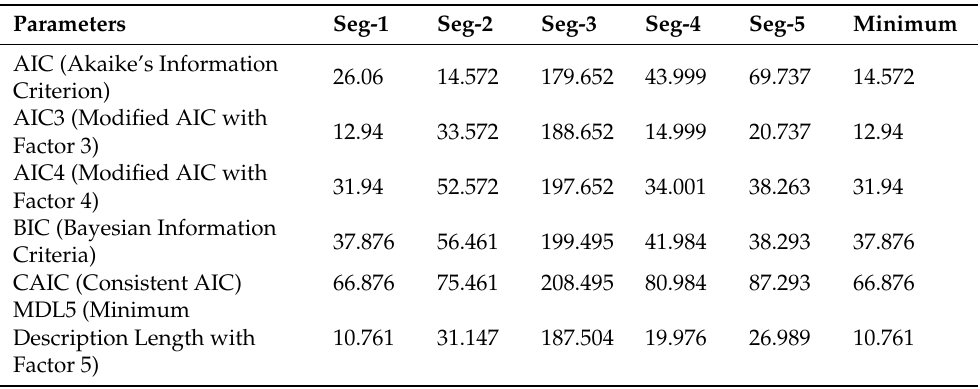
Table 13. Unobserved heterogeneity (UH)